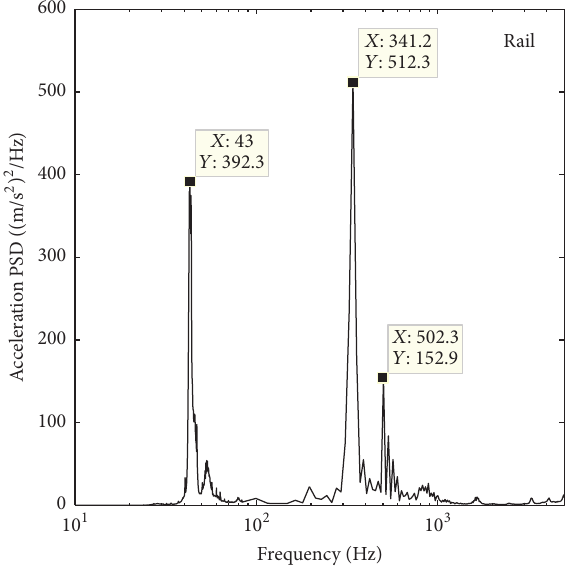
Figure 9: The acceleration power spectrum of the